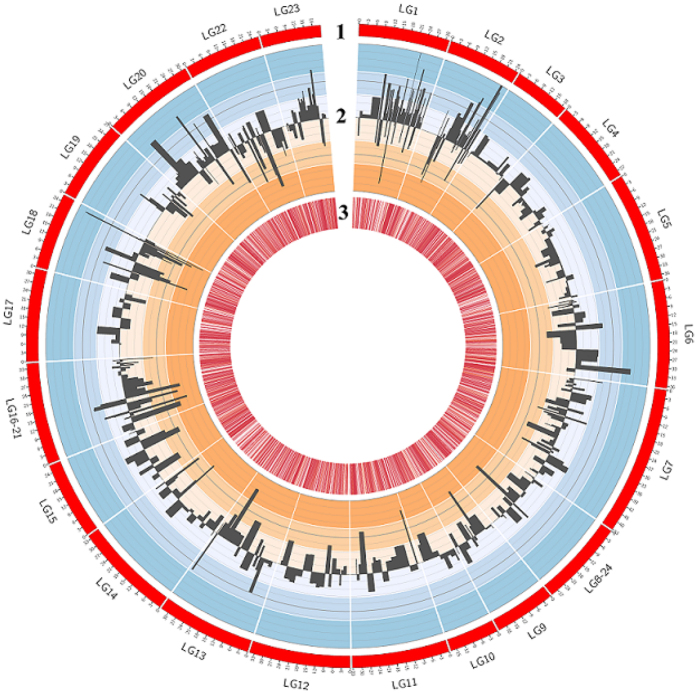
CIRCOS chart summarizing the differentially methylated regions in two sexes of hybrid tilapia.Track 1 shows an ideogram representing the 22 chromosomes in hybrid tilapia. Track 2 represents differentially methylated regions between the male and female individuals. Histograms in the blue regions show regions hypermethylated in males while orange regions show regions hypermethylated in females. Histograms were expanded for illustration purposes and histogram width is not a direct representation of DMR size. Track 3 displays the locations of all CpG islands in hybrid tilapia.